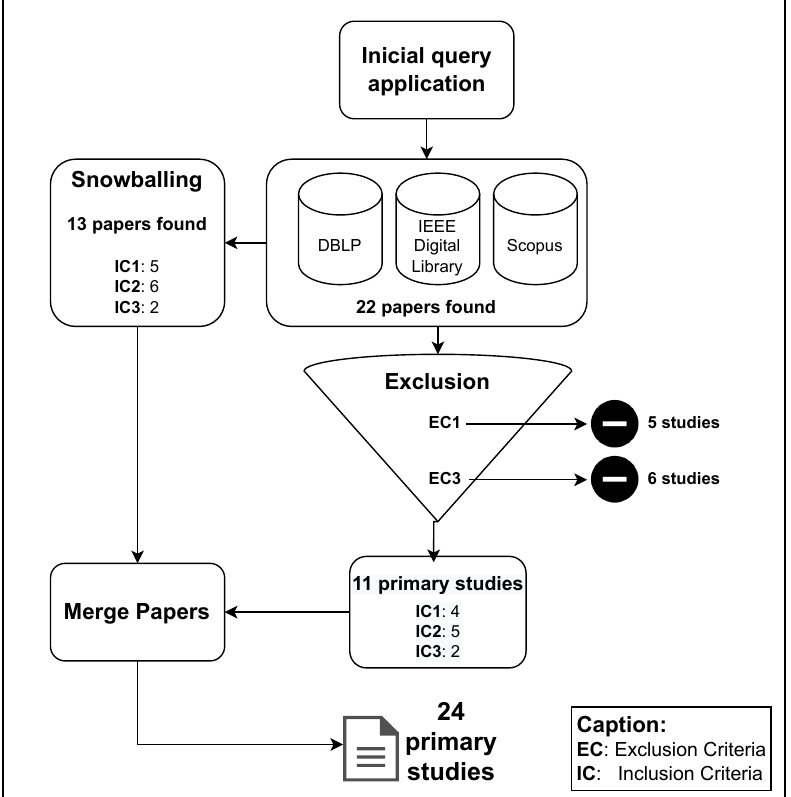
Figure 2. Filters applied in SLR